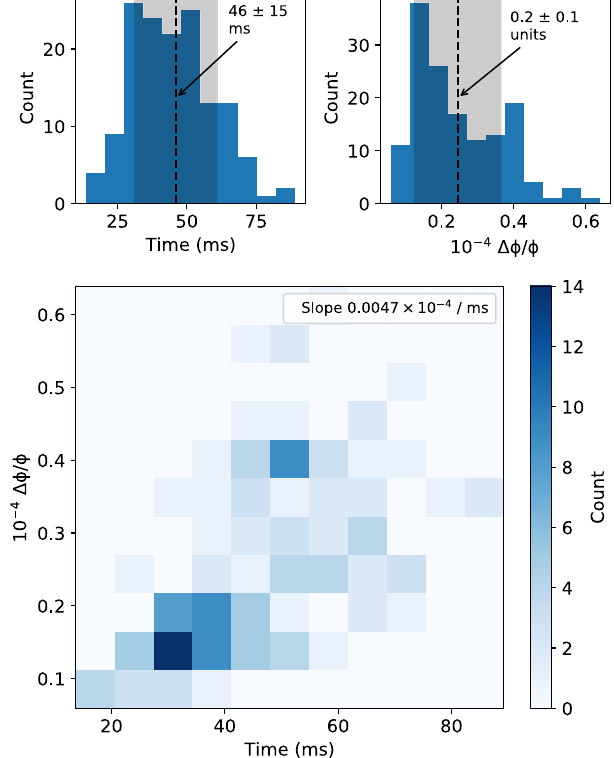
FIG. 2. Statistics of 145 manually selected flux jumps during the measurement of the magnetic flux error in the MBHSP109 model of the 11 T dipole. The top left plot shows the distribution of the rise times of the selected flux jumps. The top right plot shows the distribution of the magnetic flux change that the flux jumps produce. In the bottom plot the distribution of magnetic flux error versus rise time is